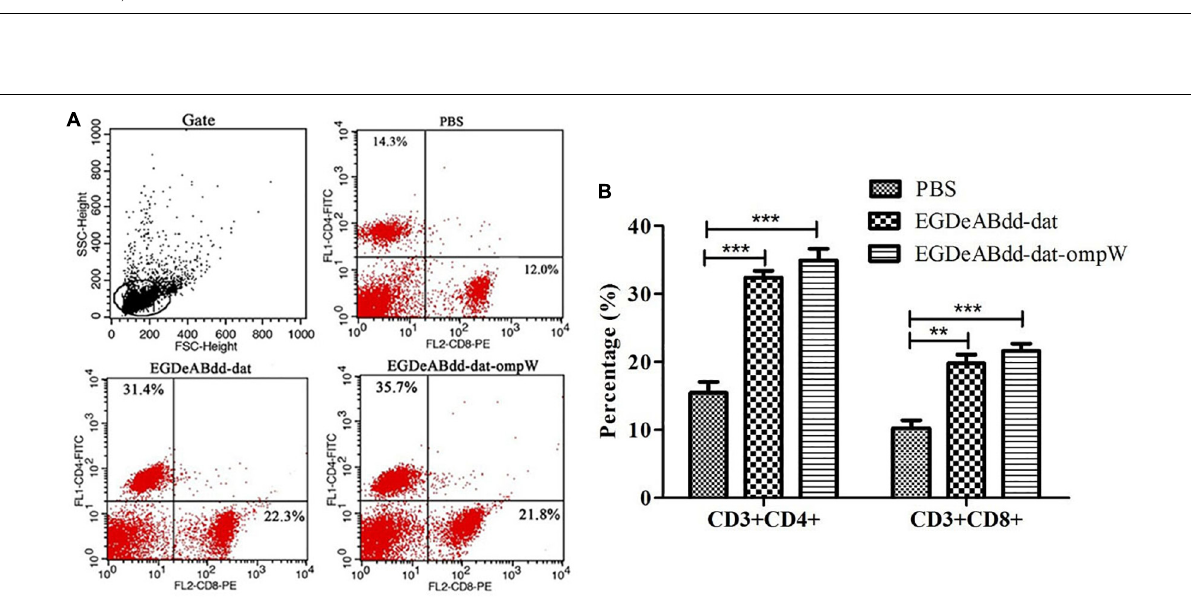
Frontiers in Microbiology |